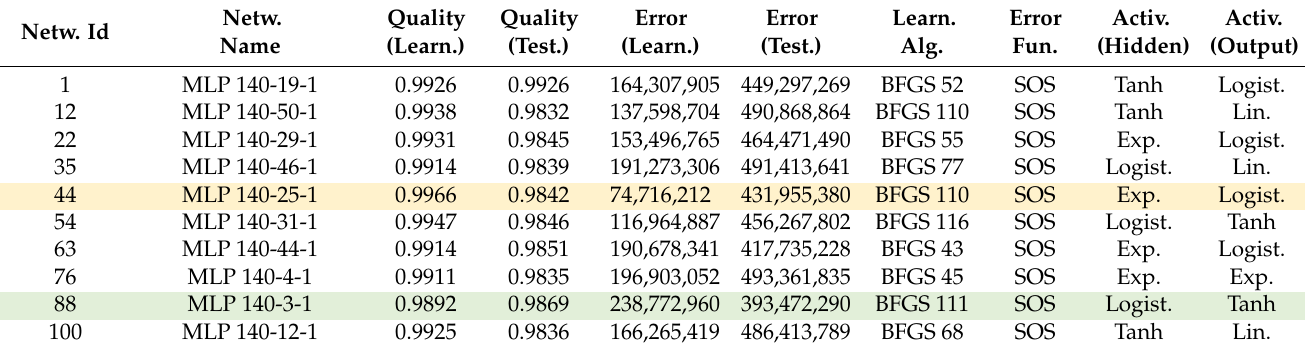
Table 4. Summary of learning of selected neural networks.